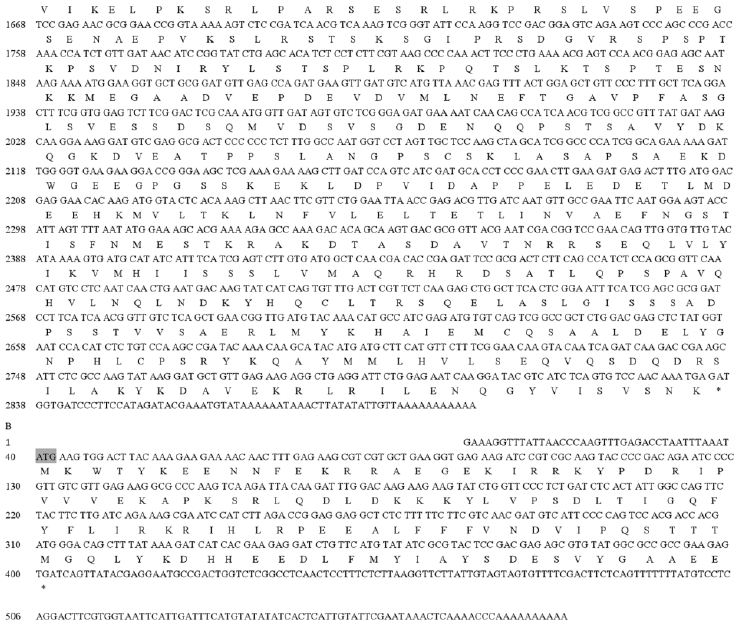
Figure 2. Full-length cDNA sequences and deduced amino acid sequence of BxATG1 ( A ) and BxATG8 ( B ) from B. xylophilus . Note: The initiation codons are shown with a dark background, and asterisks indicate the stop codons.